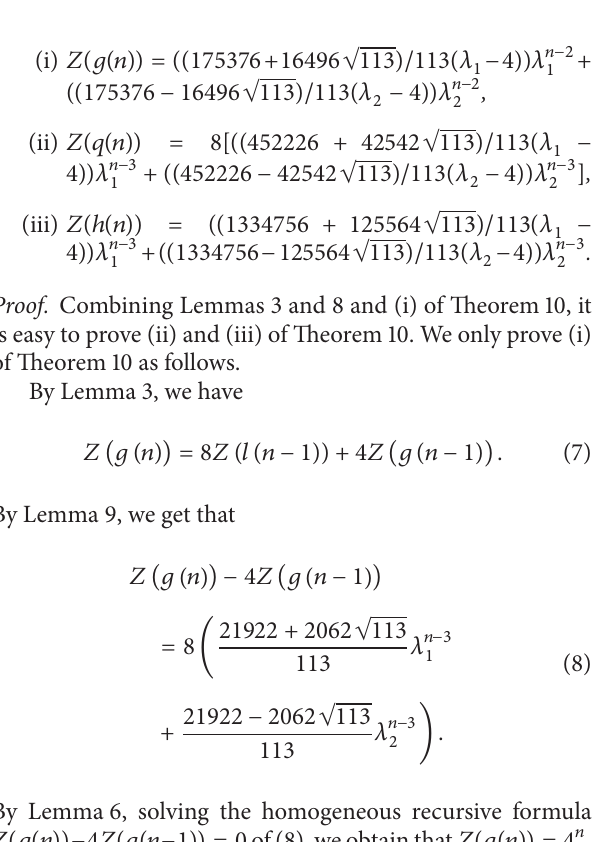
Figure 3: Chains 𝑞(𝑛) and ℎ(𝑛)